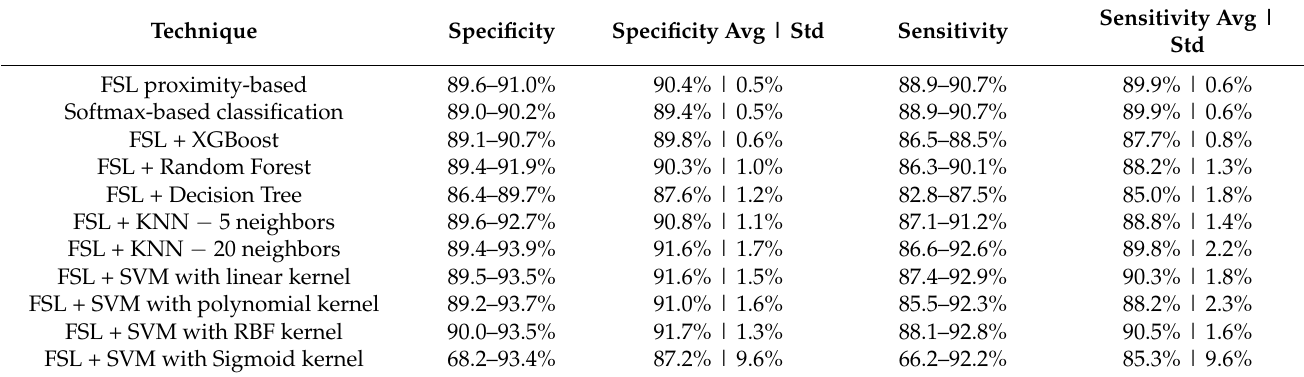
Table 3. Results for two-class classification, part II.